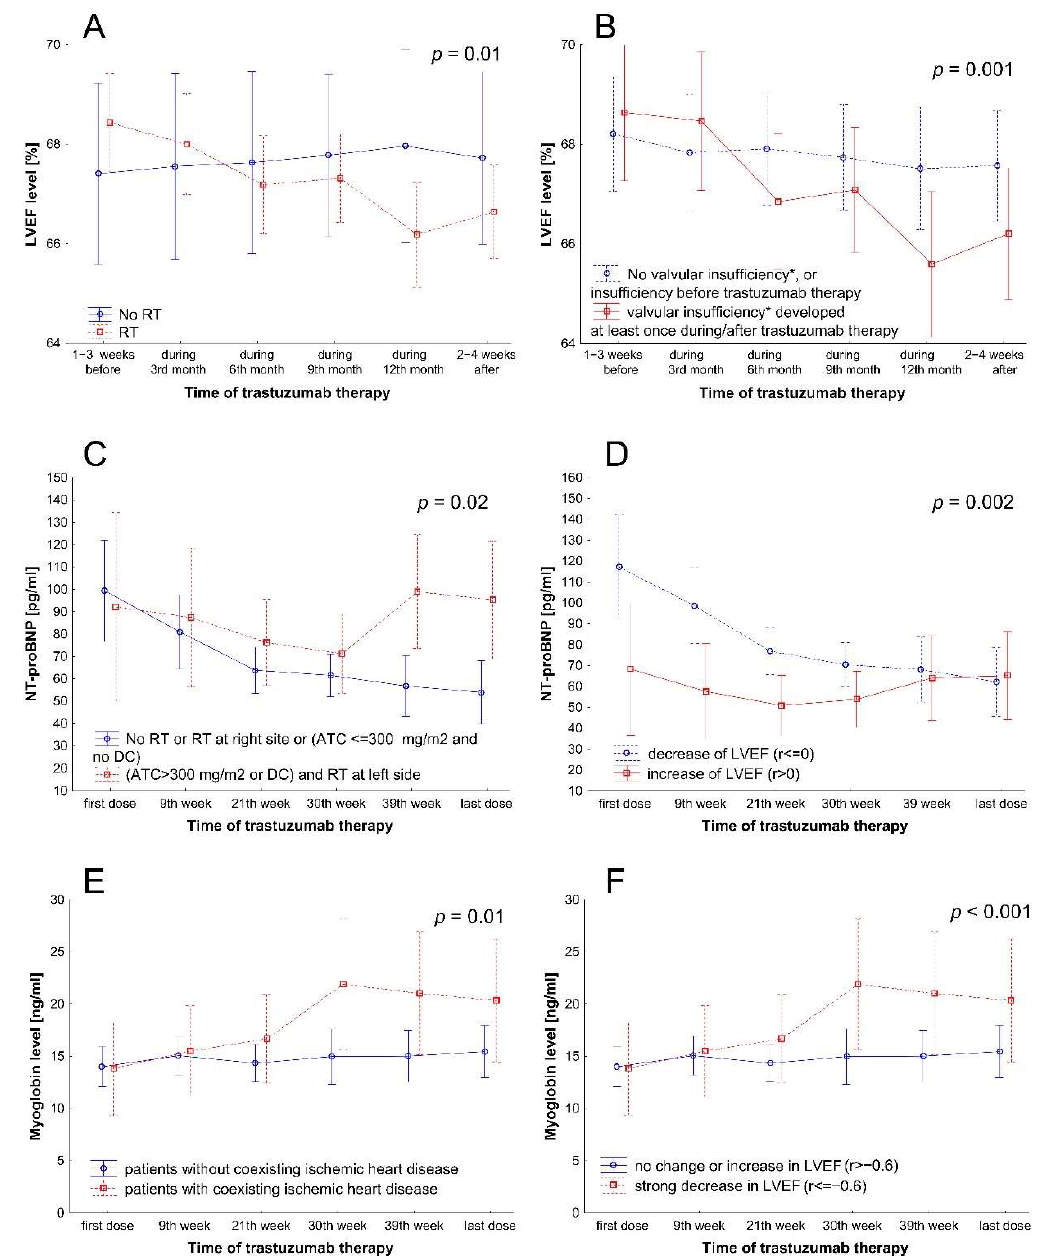
Figure 2. Changes during therapy in levels of LVEF in patients with or without radiotherapy ( A ) and in patients with different occurrence of valvular insufficiency of any grade ( B ); in levels of NT-proBNP in patients stratified according to treatment ( C ) or changes in LVEF ( D ); in levels of myoglobin in patients with or without coexisting ischemic heart disease ( E ) and in patients stratified according to LVEF changes ( F ). * Valvular insufficiency of any grade. Abbreviations: ATC, doxorubicin (anthracycline); DC, docetaxel; LVEF, left ventricular ejection fraction; NT-proBNP, N-terminal brain natriuretic peptide; RT, radiotherapy.